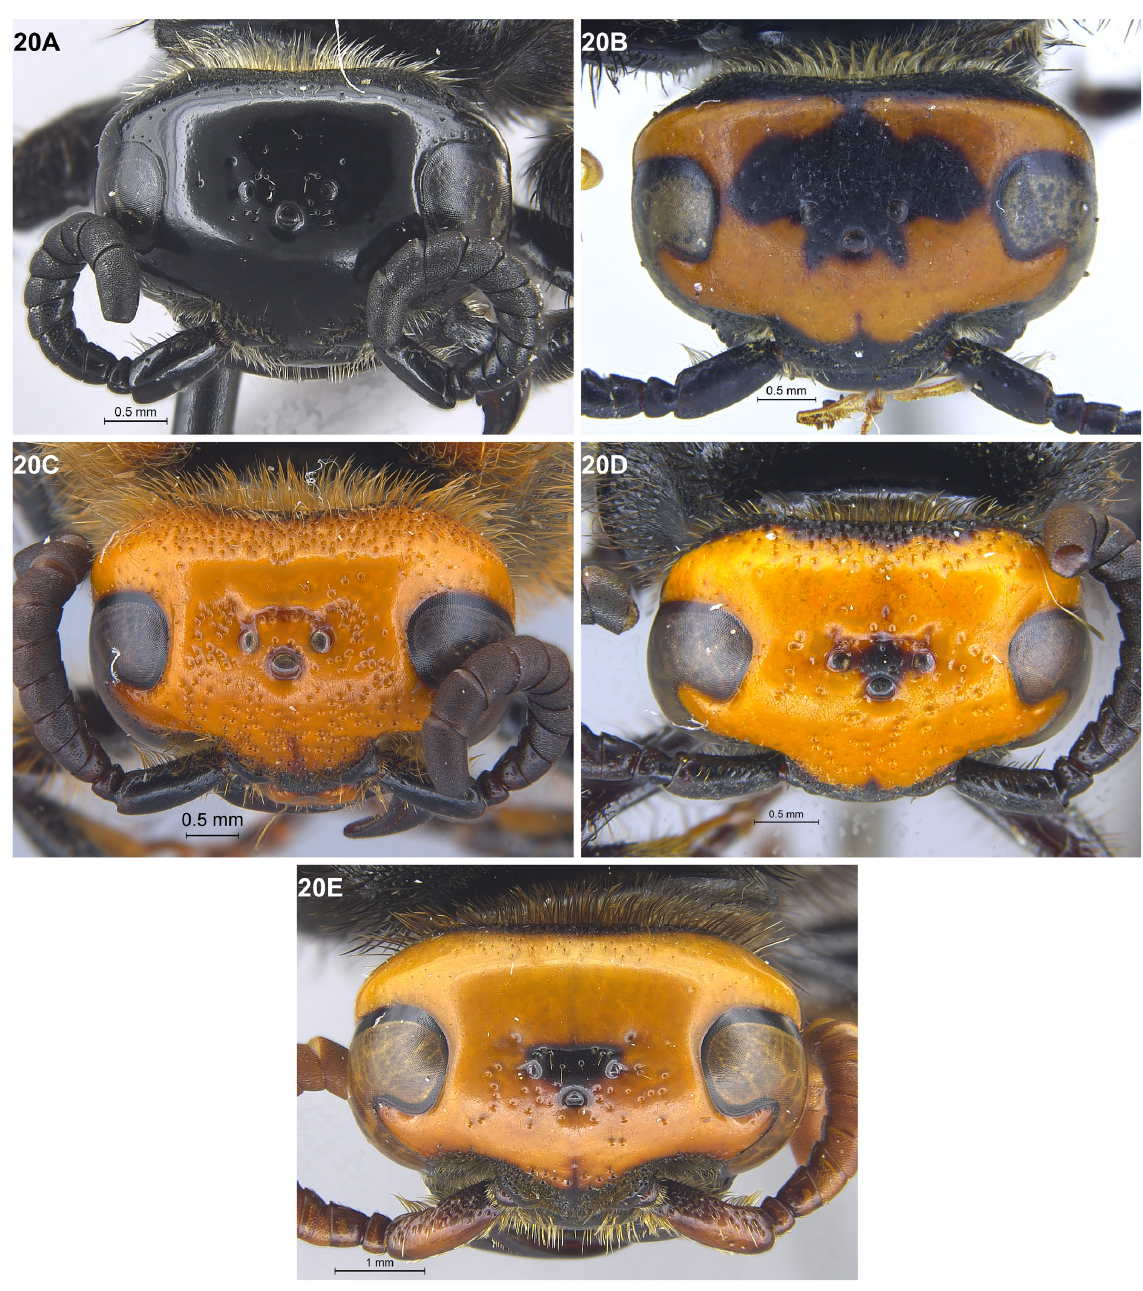
Fig. 20. Females, vertex. A . Scolia binotata Fabricius, 1804 . B . Sc. binotata orange var. C . Sc. clypeata pseudovollenhoveni Betrem, 1933. D . Sc. pakshaoensis sp. nov., holotype (CAS). E . Sc. superciliaris de Saussure & Sichel, 1864